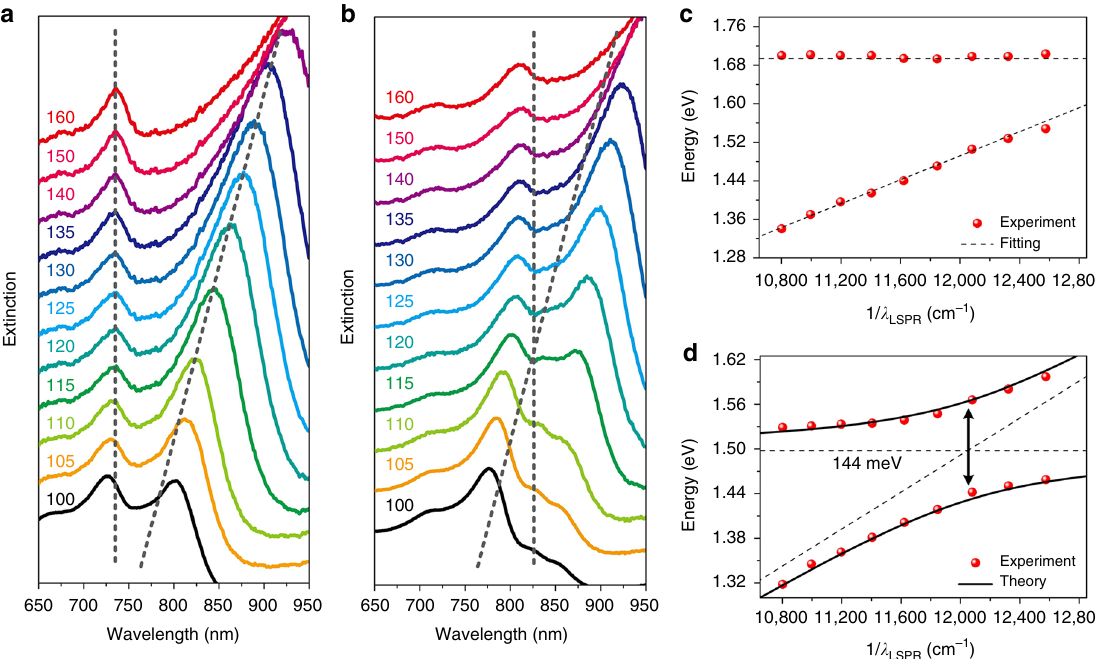
Fig. 2 Extinction spectra and energy dispersion. a , b Extinction spectra of samples with different nanoblock sizes (100 – 160 nm, indicated by the different color traces) at the fi xed period of 400 and 500 nm, respectively. The gray dashed lines indicate the variation trend of the uncoupled localized surface plasmon resonance (LSPR) mode and surface plasmon polariton (SPP)-Bloch wave with increasing nanoblock size. The vertical dashed line represents the SPP-Bloch waves, and the oblique dashed line represents the LSPR modes. c , d Dispersion of the two branches plotted against the wavenumber for the uncoupled LSPR modes corresponding to a and b , respectively. The dashed lines correspond to the dispersion of the uncoupled LSPR mode and SPP-Bloch wave. The horizontal line represents the energy of the SPP-Bloch wave, and the oblique line represents the energy of the LSPR mode. The solid lines in d correspond to the real part of the eigen-energies of the coupled modes calculated by the coupled oscillator model with a splitting energy of 144 meV at E = E LSPR